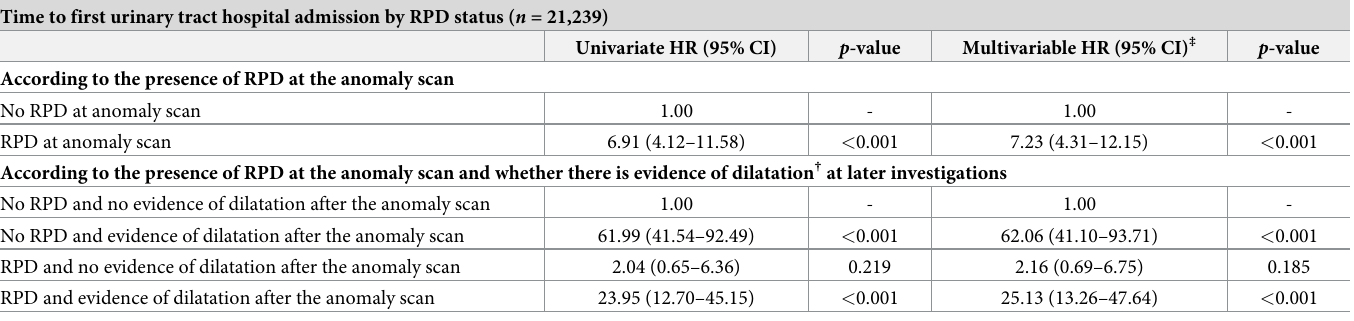
Table 3. HRs for time to first urinary tract hospital admission by RPD status at anomaly scan. Time to first urinary tract hospital admission by RPD status ( n =